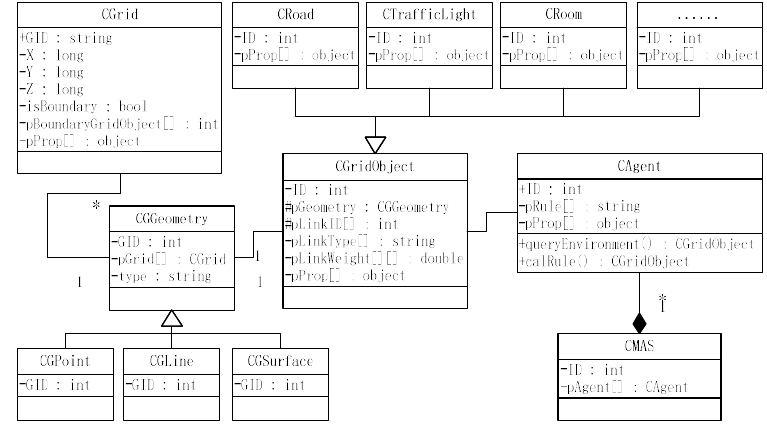
Figure 4. UML class diagram of the GOAM for individual behavior simulation.